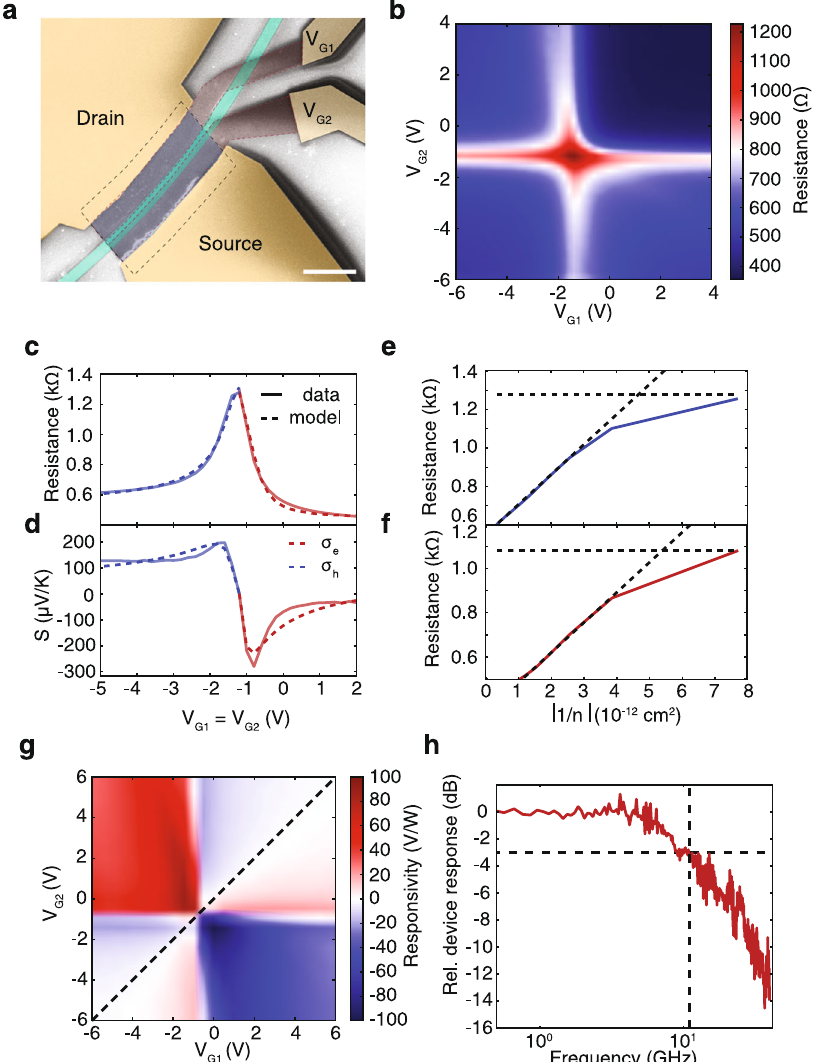
Fig. 4 GPD characterisation. a False-colour SEM image of our GPD, showing Cr/Au contacts (yellow), Si WG (green), contacted hBN/SLG/hBN (blue, dashed line under contacts), and SLG gates (red). Scale bar: 2 μ m. b Resistance map demonstrating independent tunability of charge carrier concentration in the SLG channel via V G1 and V G2 . c Electrical characterization at homogeneous channel doping (solid lines, measured data; dashed lines, model). d Calculated S based on the electrical data in c . e , f ) Resistance vs. inverse carrier concentration for e electron and f hole doping. g Photoresponse at zero bias on resonance ( λ = 1555.87 nm). h Frequency response. The 3-dB cutoff frequency, marked by intersecting dashed lines, is ~12 GHz.